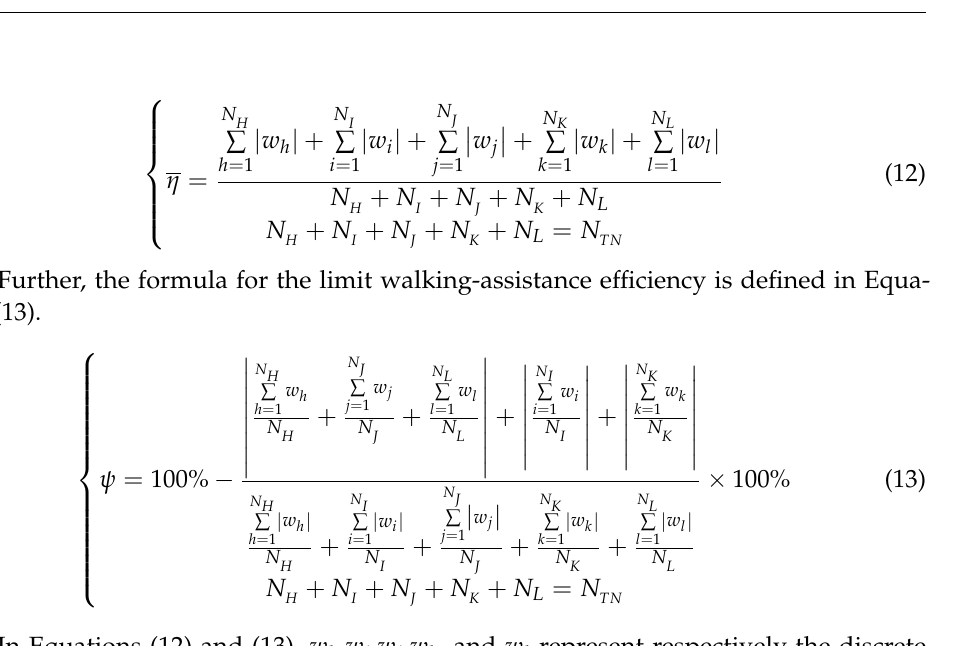
Figure 12. Joint power with the KESM under different stiffness values. There were significant amplitude differences between the joint powers during the support period and the high similarity during the swing period [25,28]. This indicates that the KESM affects the body during the support period, and this interaction has a positive effect on the movement of the knee joint. To objectively judge the walking ‐ assistance effi ‐ ciency of the KESM, this paper introduced a calculation formula to measure the overall distribution of the knee joint power, which is based on the consideration of the discrete data results. The formula based on the average is shown in Equation (14), and the limit walking ‐ assistance efficiency formula of the KESM is defined in Equation (15).